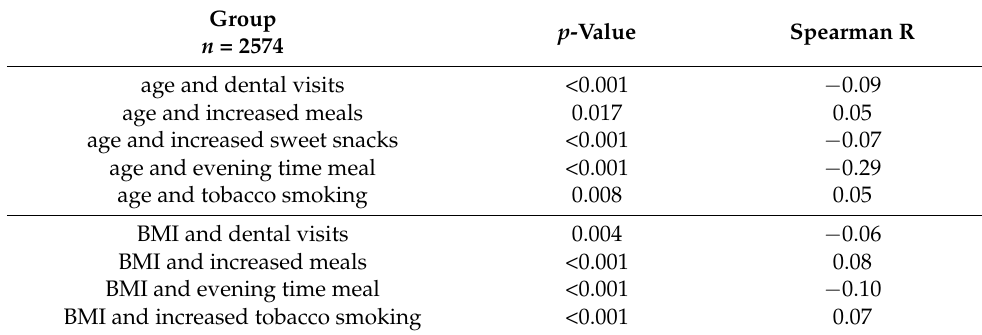
Table 2. The Spearman’s correlation rank tests showed significant results regarding age, BMI, and selected parameters ( p < 0.05) for all surveyed participants.